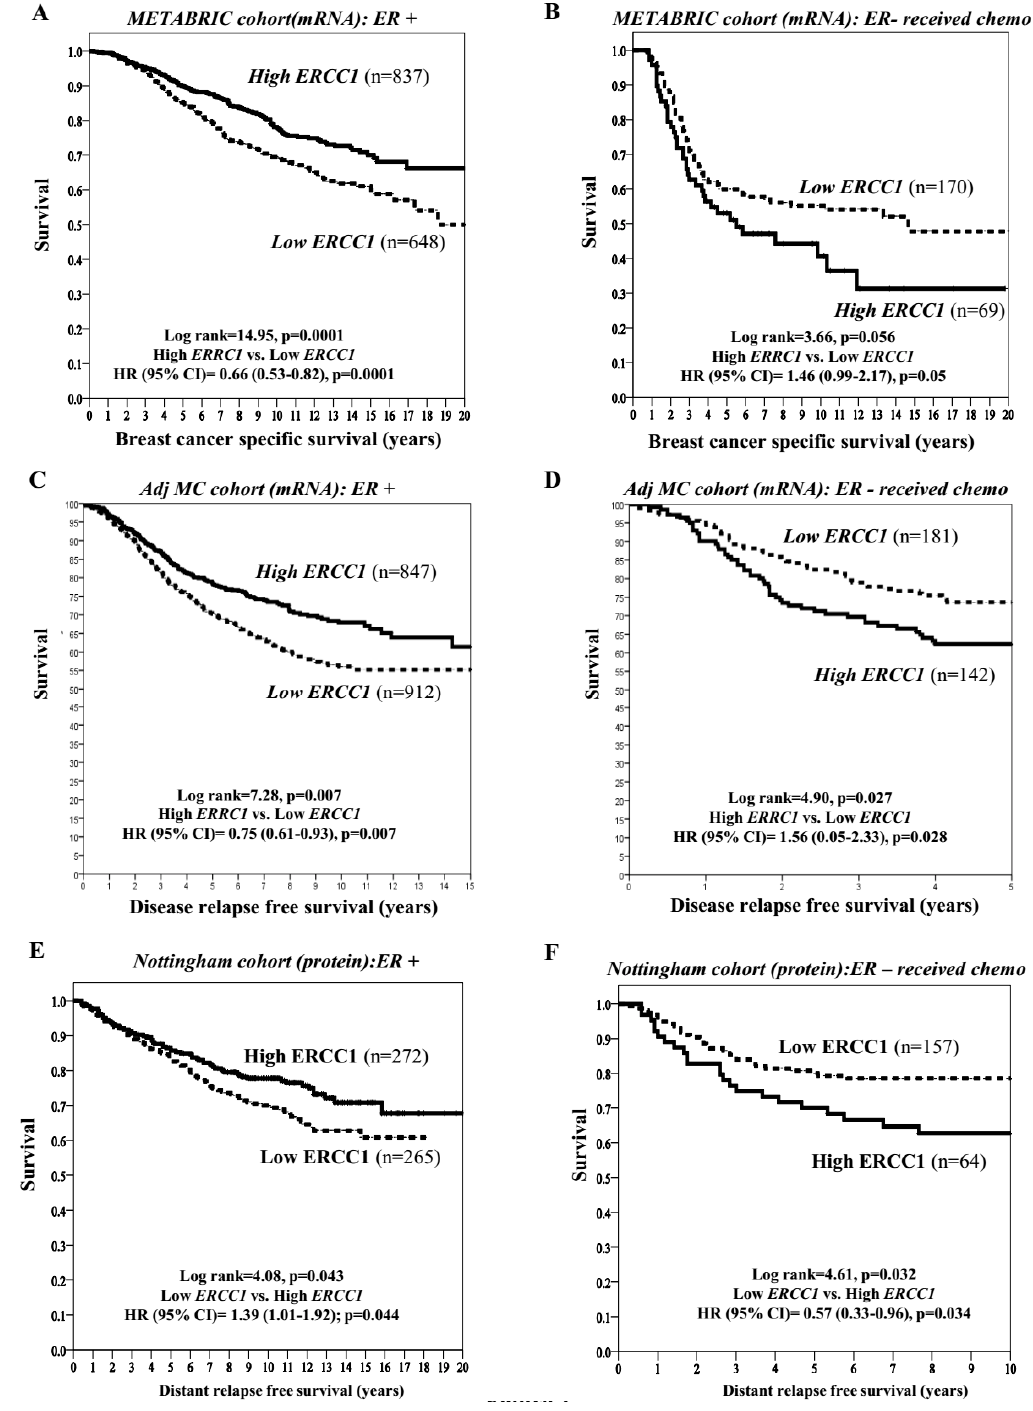
Figure 1. ERCC1 , adjuvant chemotherapy and survival. ( A ) Kaplan Meier curves showing BCSS (Breast cancer specific survival) based on ERCC1 mRNA expression in ER + METABRIC cohort. ( B ) Kaplan Meier curves showing BCSS (Breast cancer specific survival) based on ERCC1 mRNA expression in ER − METABRIC cohort. ( C ) Kaplan Meier curves showing disease specific survival based on ERCC1 mRNA expression in ER + Multicentre Adjuvant (Adj MC) cohort. ( D ) Kaplan Meier curves showing disease specific survival based on ERCC1 mRNA expression in ER − Adj MC cohort. ( E ) Kaplan Meier curves showing disease specific survival based on ERCC1 protein level in ER + Adj MC cohort. ( F ) Kaplan Meier curves showing disease specific survival based on ERCC1 protein level in ER − Adj MC cohort.